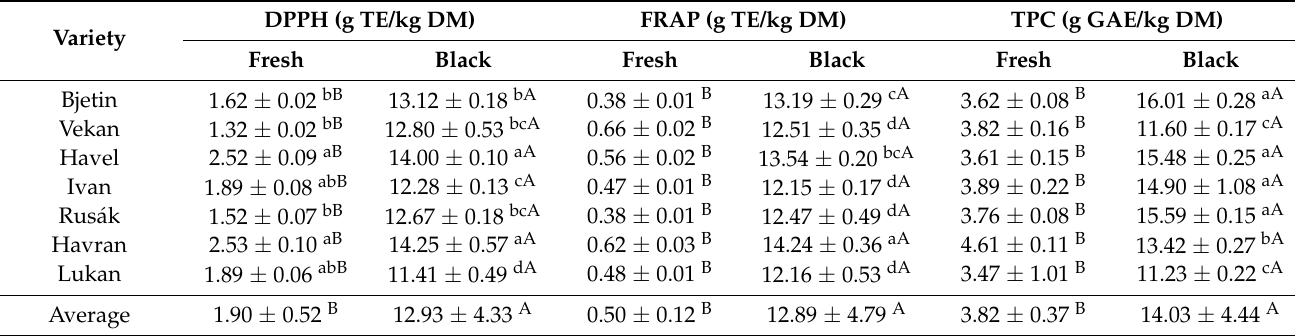
Table 2. Antioxidant activity (DPPH and FRAP assays) and total polyphenol content (TPC) of fresh and black garlic varieties.